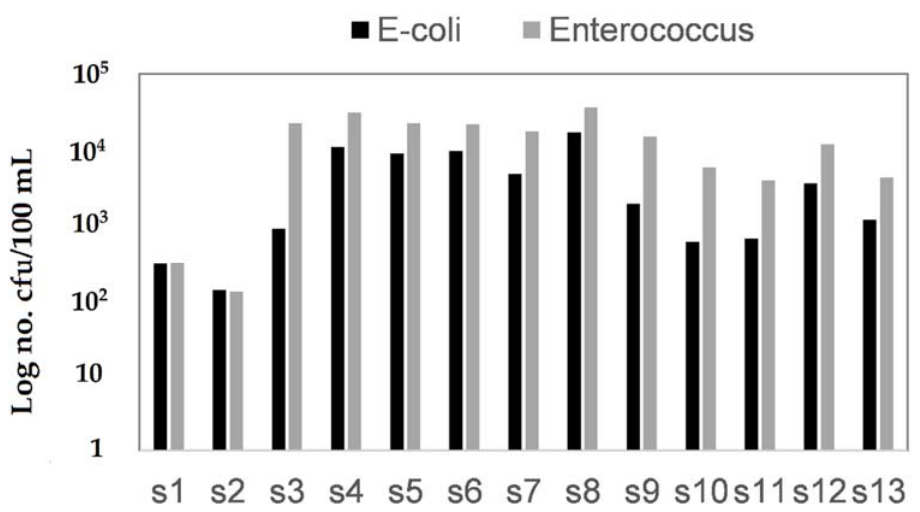
Figure 2. E. coli and Enterococcus spp. numbers in stormwater samples. S1 is dry weather sample and S2–S13 are wet weather samples collected between March 2011 to April 2012.